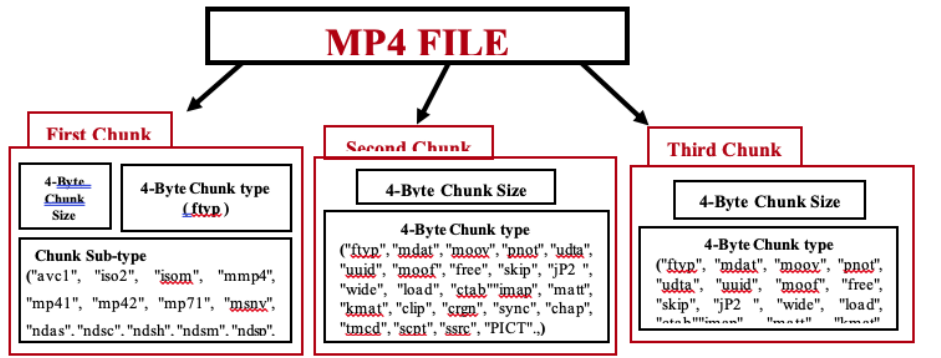
Figure 4. MP4 file